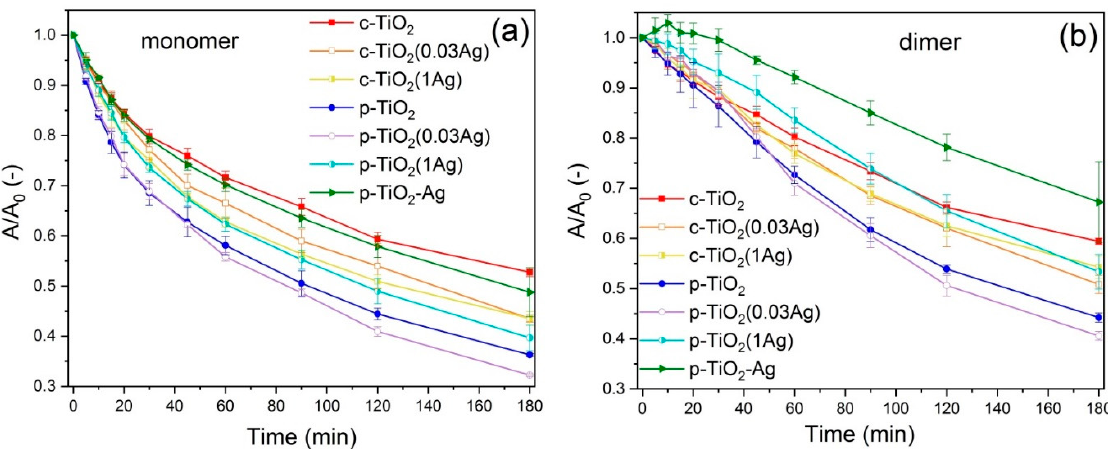
Figure 6. A/A 0 − t curves of Rhodamine 6G monomer and dimer degradation under visible light.